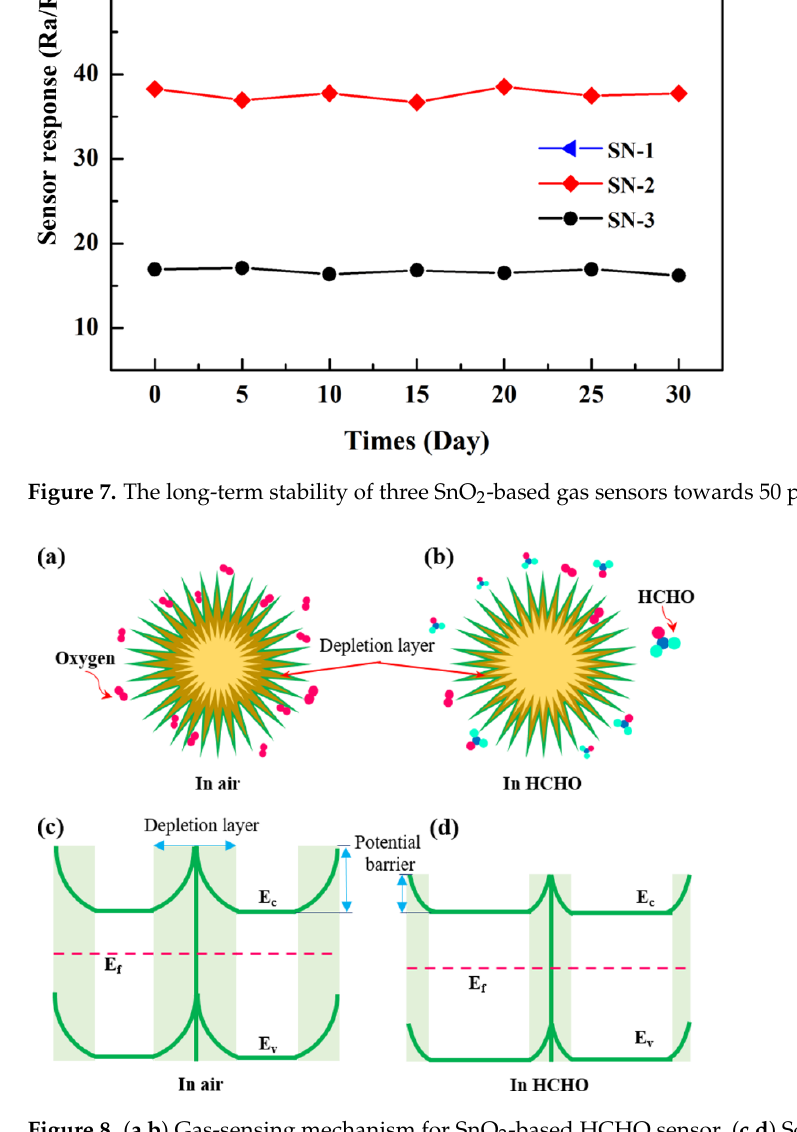
Figure 8. ( a , b ) Gas-sensing mechanism for SnO 2 -based HCHO sensor. ( c , d ) Schematic energy level diagram of SnO 2 before and after exposure to HCHO.